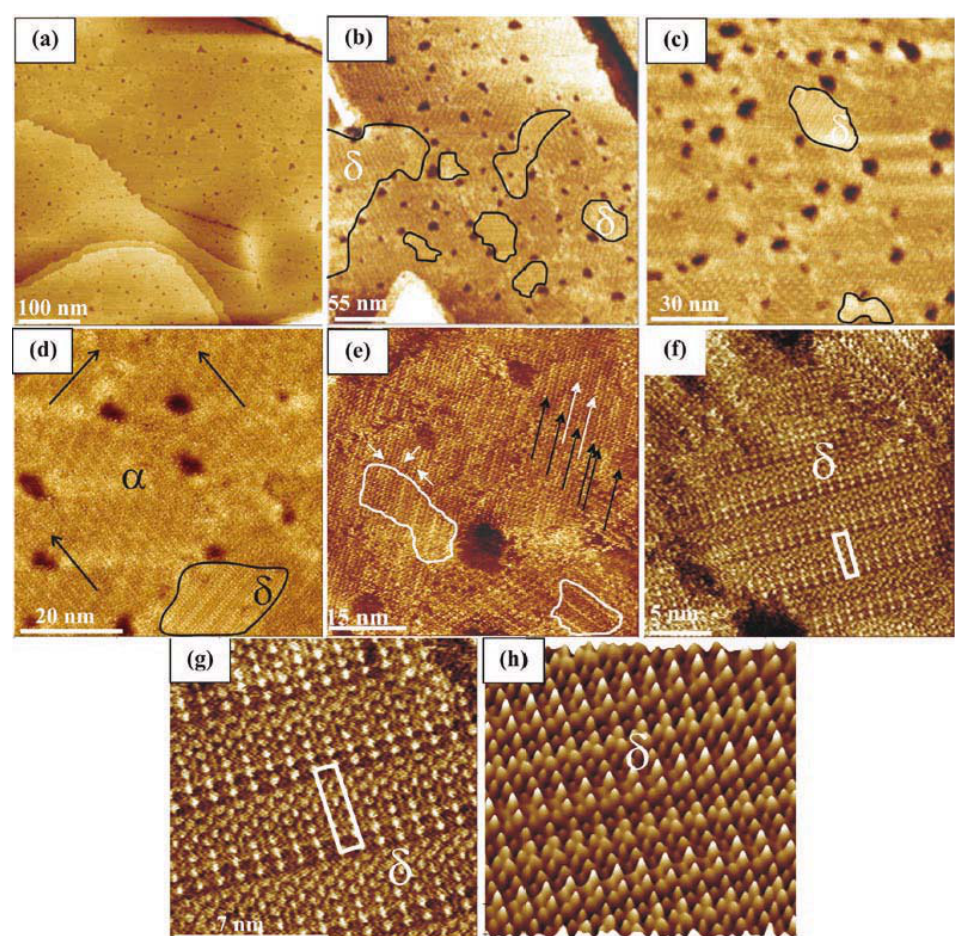
Figure 6. (a)-(g) constant-current STM images showing the gold surface after immersion into 100 μM ethanolic solution of BP2 at 348 K for 2 h. The regions confined by the loops in (b-d) show the δ -phase. The unit cell of the (7 √ 3×3) structure is marked by rectangles in (f) and (g); (h) a 3-D representation of image showing (7 √ 3×3) structure of BP2 SAMs. (a) U= 950 mV; I= 450 pA, (b) U=950 mV; I= 450 pA, (c) U= 950 mV; I= 450 pA, (d) U= 750 mV; I= 350 pA, (e) U= 750 mV; I= 337 pA, (f) U= 450 mV; I= 150 pA, (g) U=450 mV; I= 137 pA, (h) U= 450 mV; I= 137 Along the lines B and C, every sixth molecule has the same topographic height ( i.e., five different variations in contrast for the adsorbate organic thiol BP2 molecules).